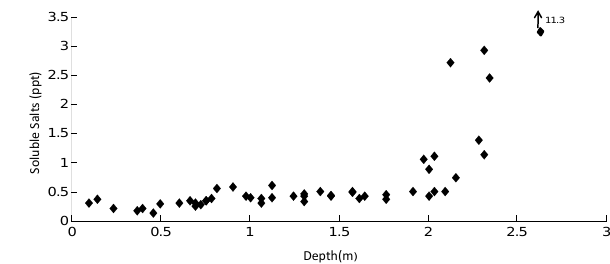
Fig. 2. (a) Soil stratigraphy interpolated from soil texture analysis, view from the side and (b) looking swampward from levee.